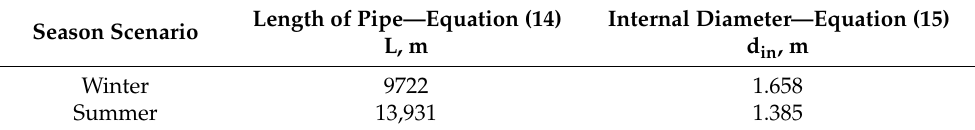
Table 2. Replacement pipeline parameters for heat source operation scenarios. Season Scenario